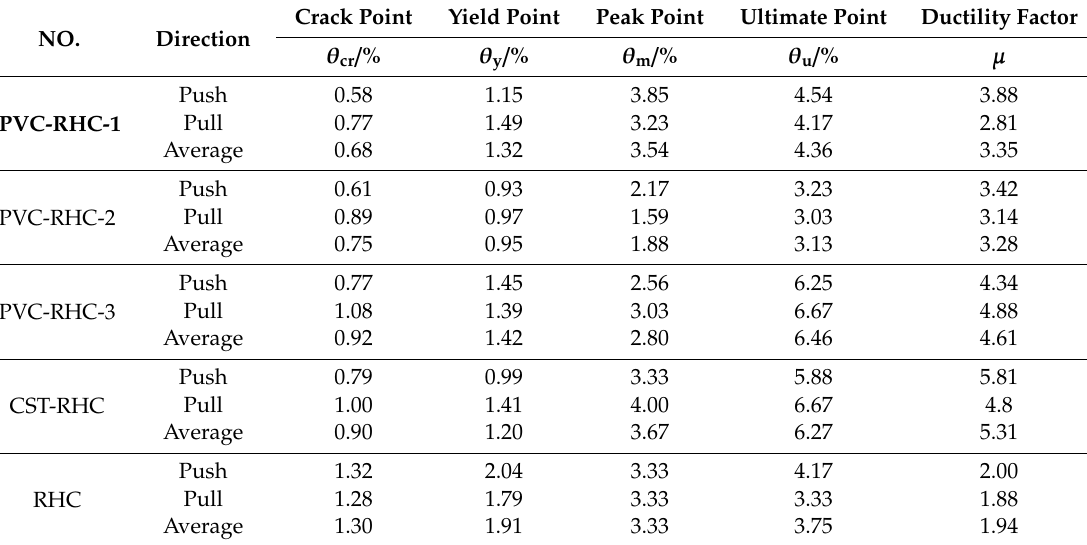
Table 5. Inter-story drift ratio and ductility of each characteristic point.